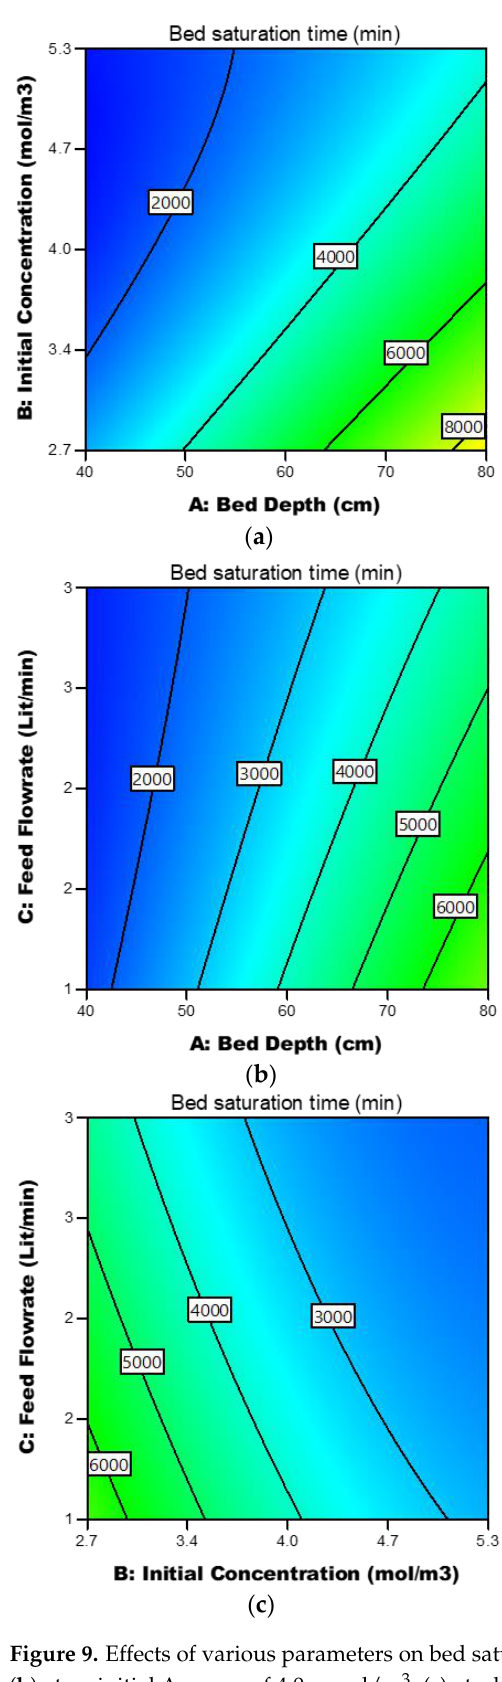
Figure 8. Effects of various parameters on As removal efficiency R1: ( a ) at a feed flow rate of 2 L/min;